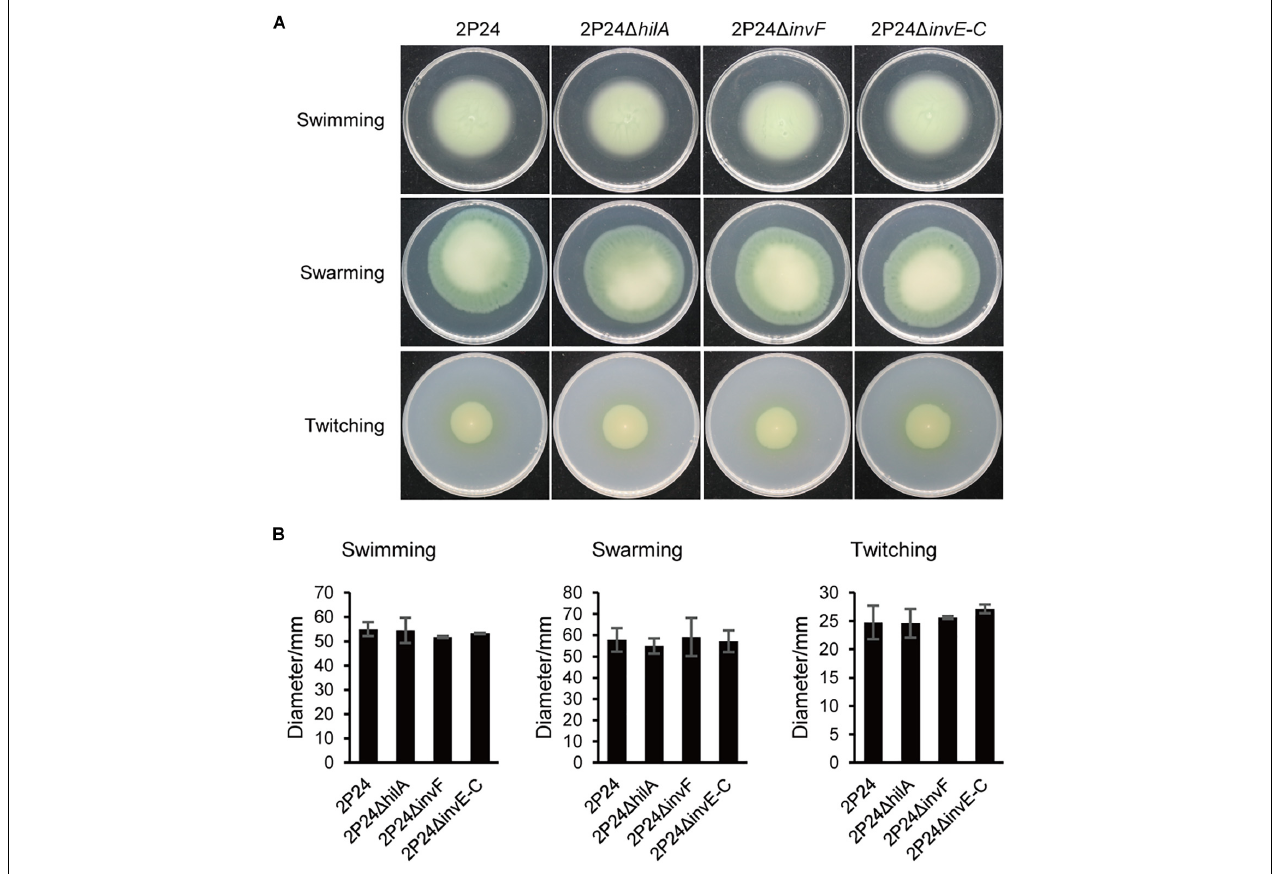
FIGURE 6 | Motility of strain 2P24 and SPI-1 related mutants. (A) Swimming on the 0.2% agar-contained KB medium for 42 h, swarming on the 0.5% agar-contained KB medium for 48 h, and twitching in the 1% agar-contained KB medium for 96 h. (B) Quantitative analysis of swimming, swarming, and twitching of strain 2P24 and SPI-1 related mutants. Data are means of three replicates. Error bars represent SD.